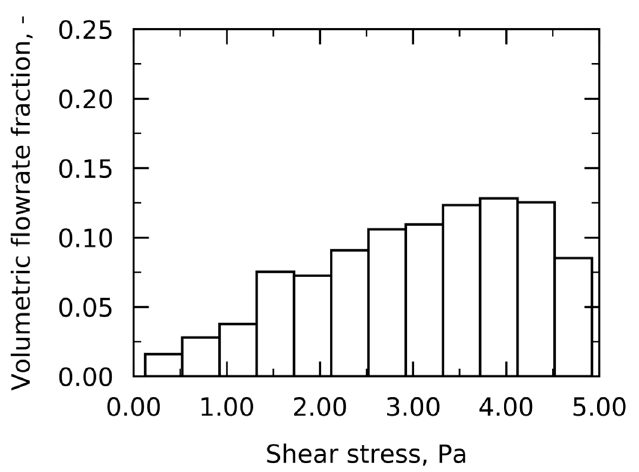
Figure 6. Shear stress distribution weighted on normalized volumetric flowrate under turbulent conditions.